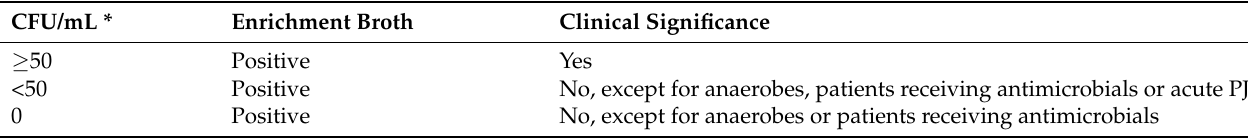
Table 1. Sonication fluid culture interpretation